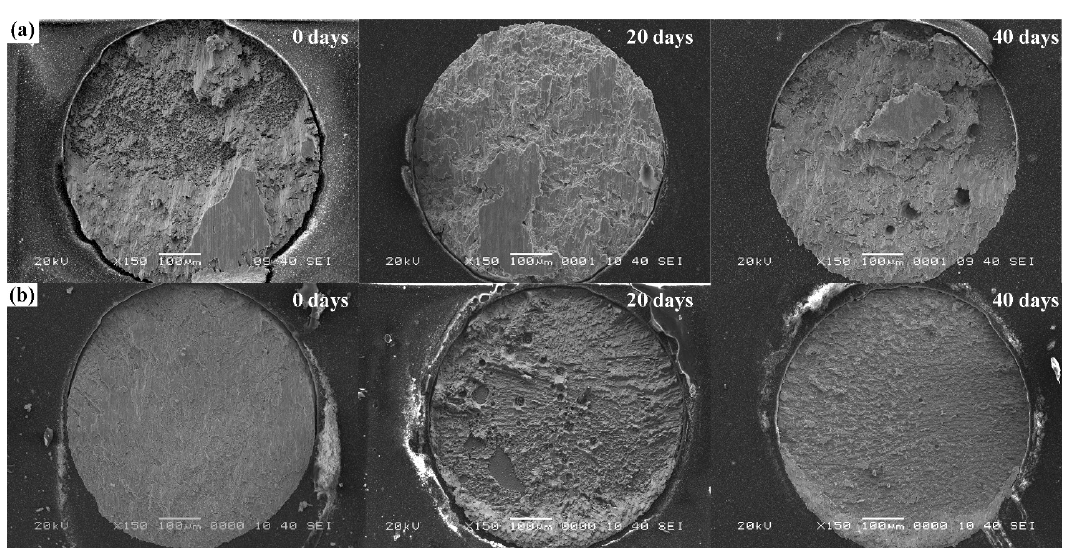
Figure 9. Fracture morphologies in ( a ) Sn-38Bi-1.5Sb-0.7Ag and ( b ) Sn-58Bi solder joints.